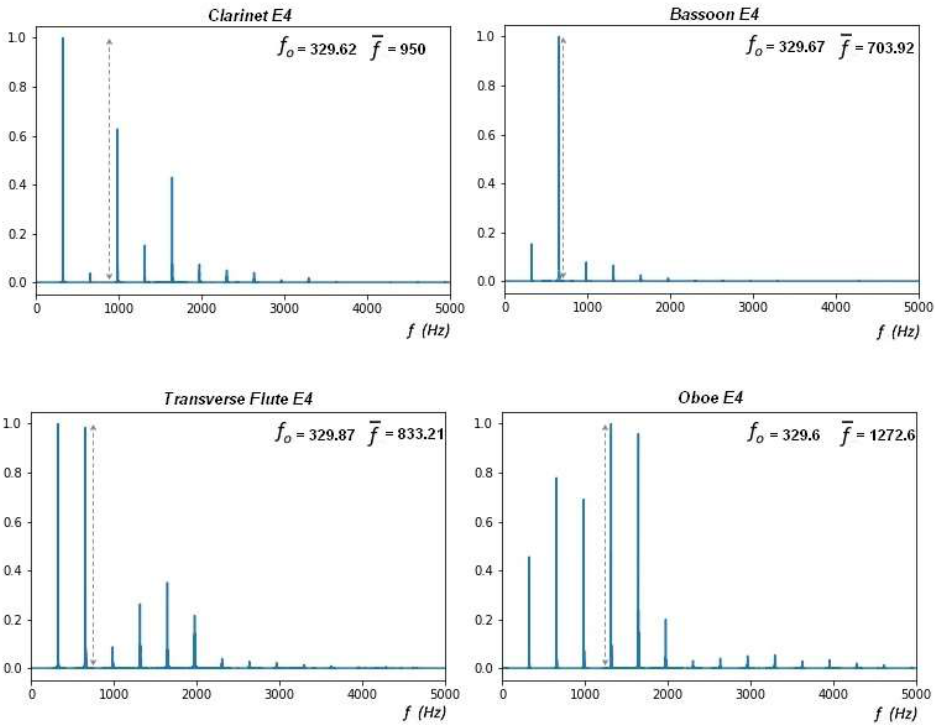
Figure 2. Variation of the centroid concerning the common tessitura of the wooden aerophones studied: Bassoon (Bn), Oboe (Ob), Transverse Flute (Fl), Clarinet in Bb (ClBb). For comparison pur- poses, the location of the musical notes of the scale below the abscissa axis is also included.